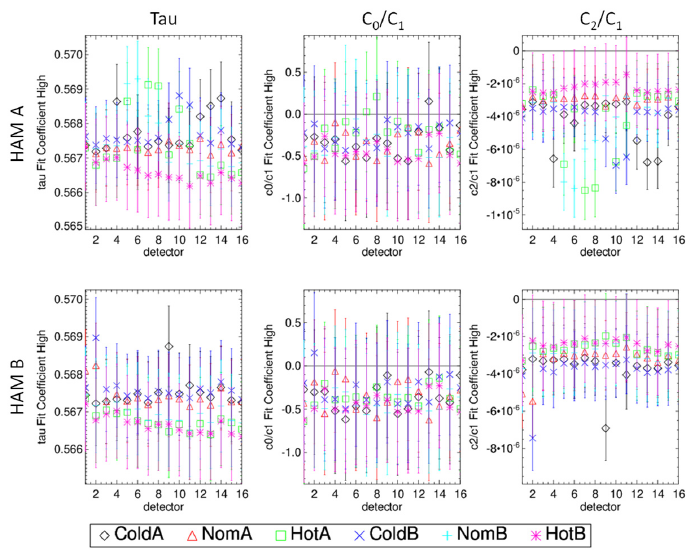
Figure 13. Band M1 high gain fit coefficients for all detectors ( x -axis) and TVAC/electronics configurations (colors and symbols). The columns are tau, c 0 nominal, and hot plateaus and electronics sides A and B are shown here.